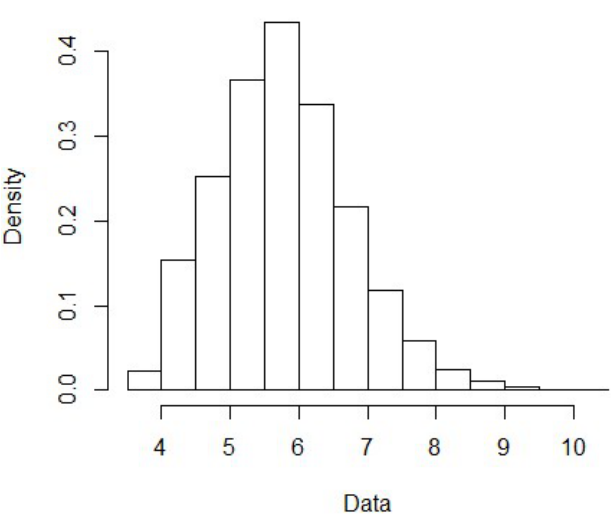
Figure 2. Histogram of logarithm of incurred losses.